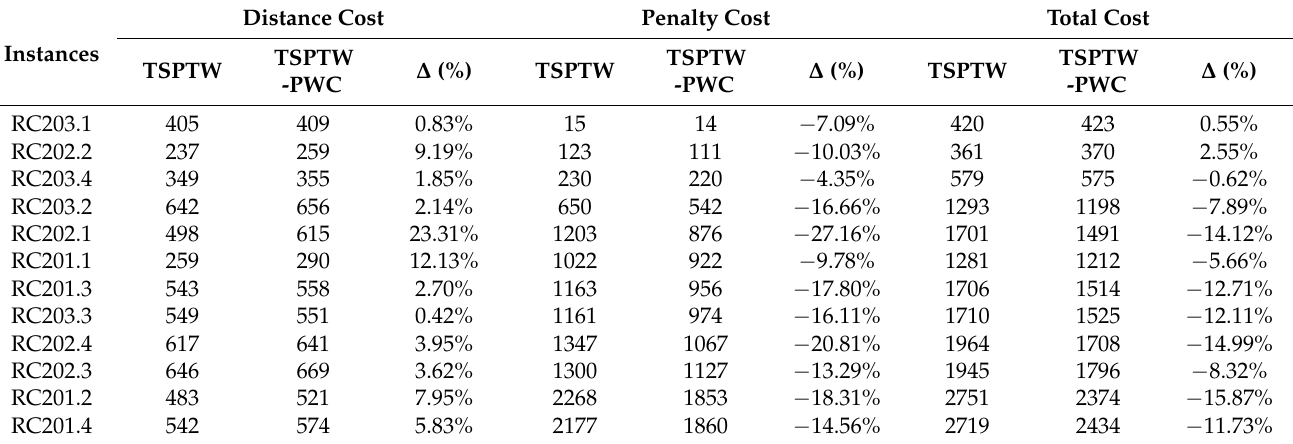
Table 2. Comparison of TSPTW and